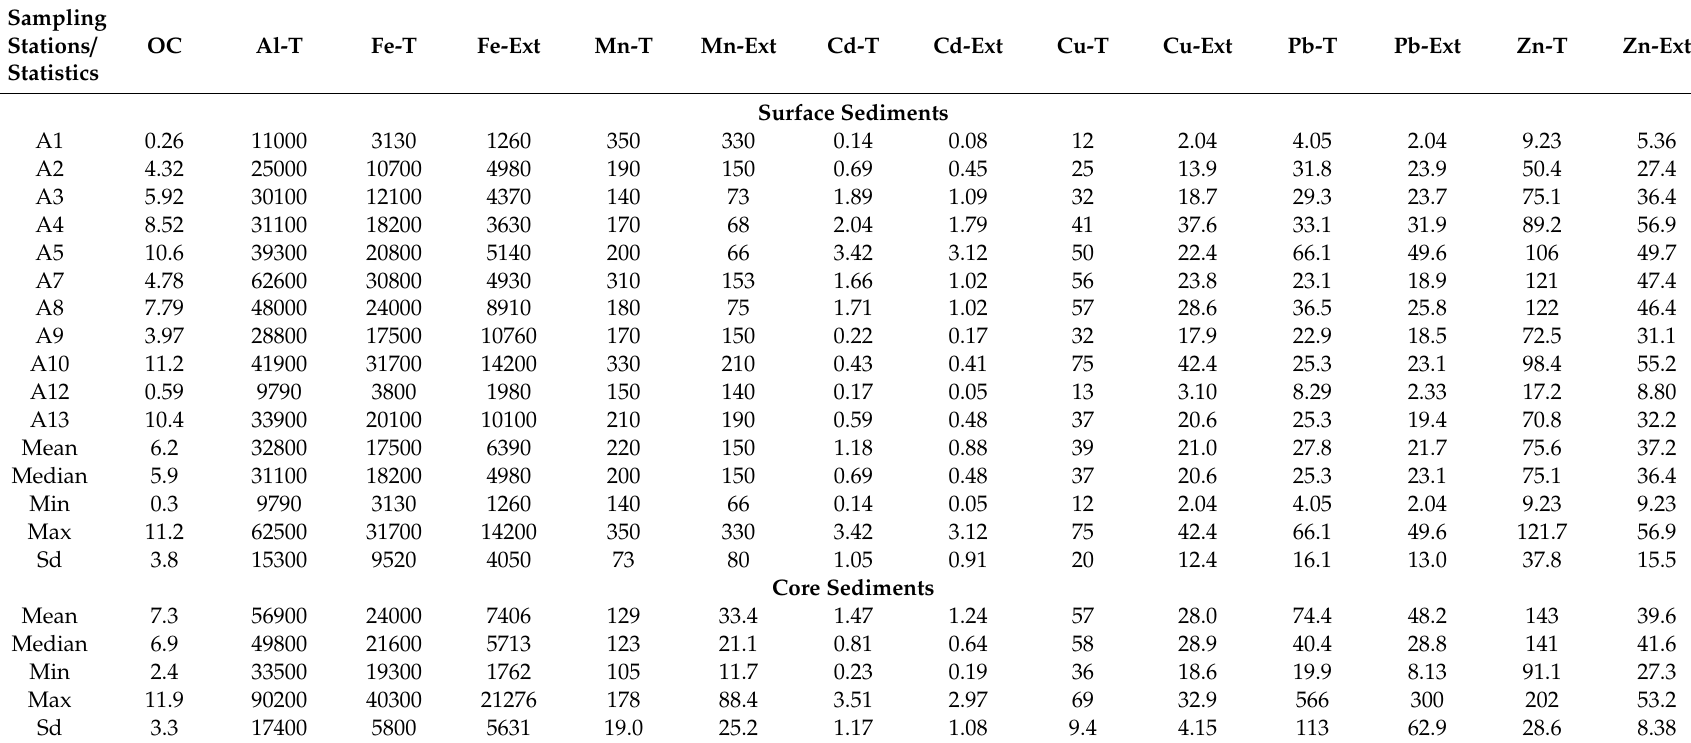
Table 4. Organic carbon (OC in%), total (T in mg · kg − 1 ) and 0.5 N HCl extractable (Ext in mg · kg − 1 ) metal contents in the surficial and core